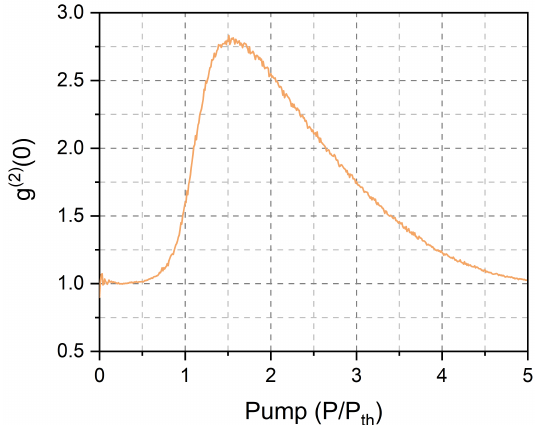
Figure 1. Second-order autocurrelation function ( g ( 2 ) ( 0 ) ) of laser emission with